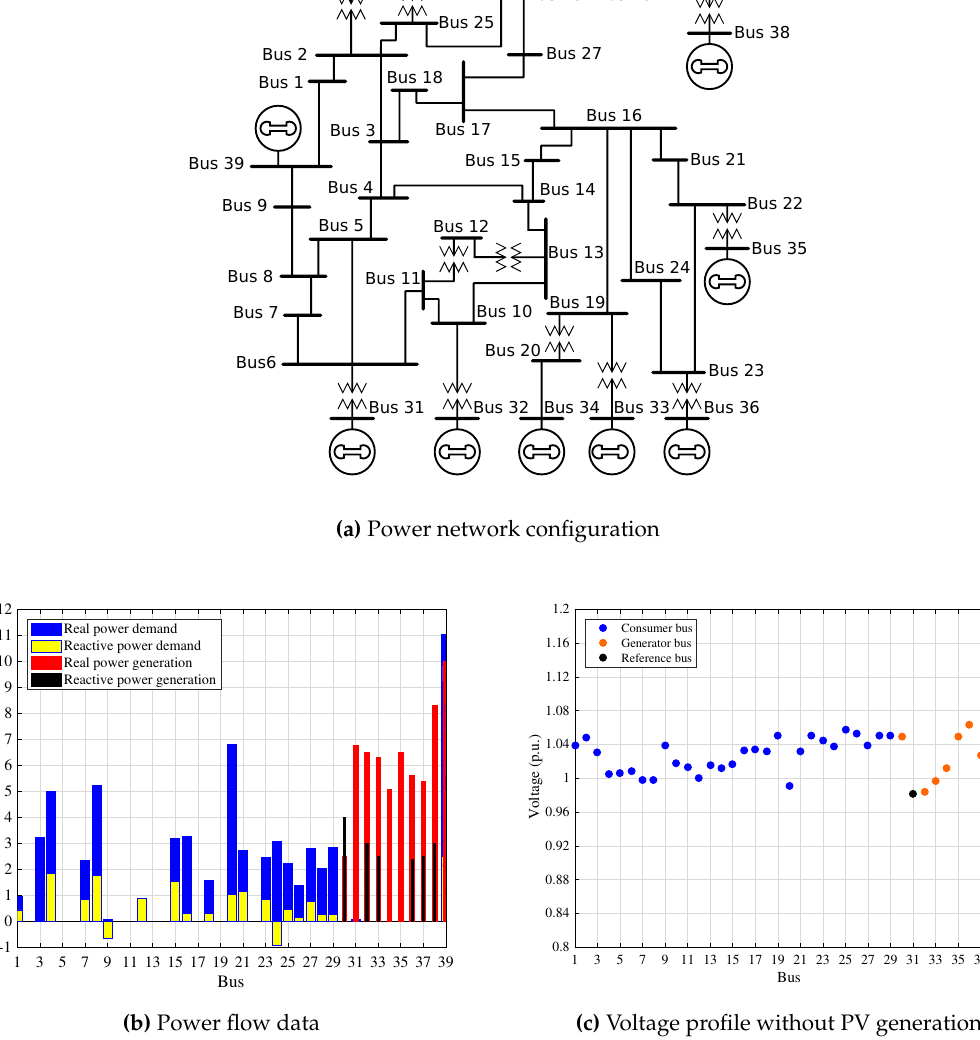
Figure 1. Information of a benchmark example: the 39-bus power